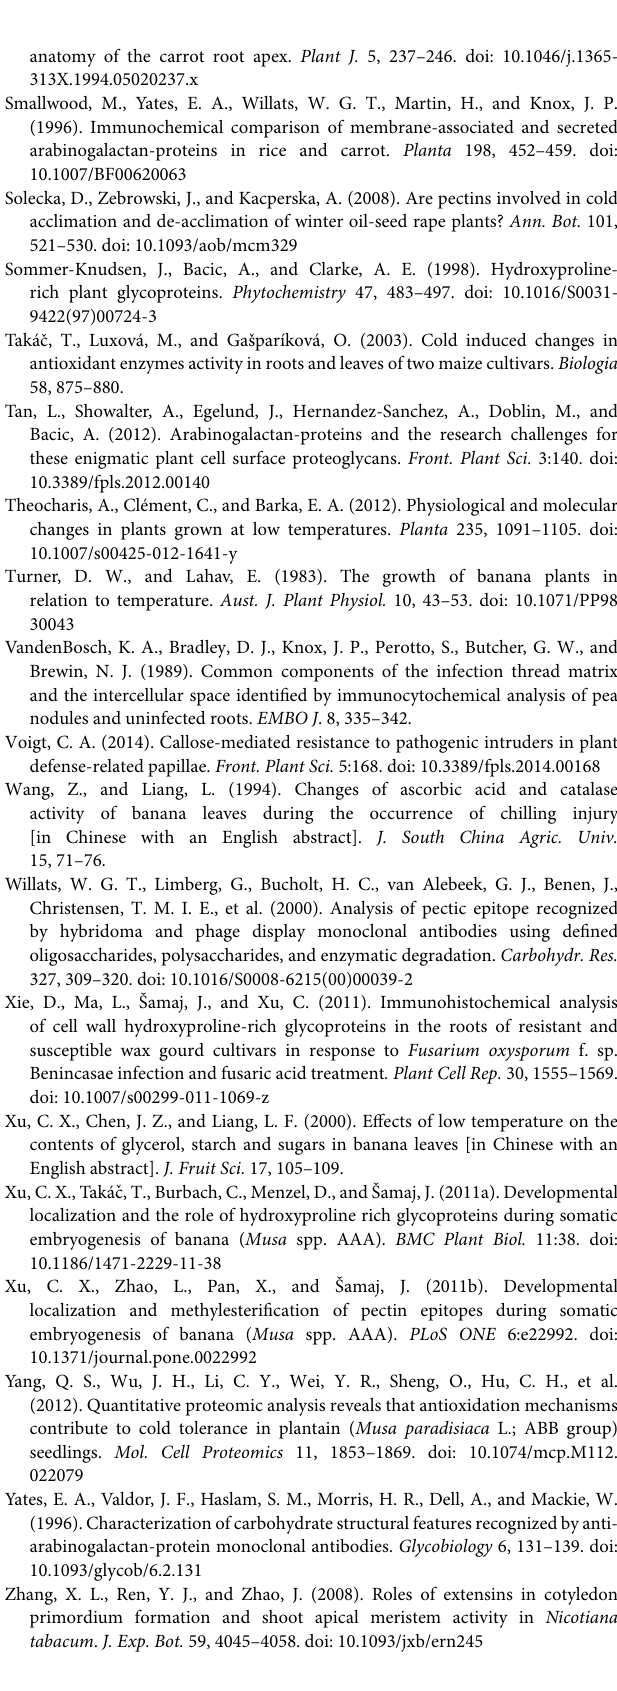
tabacum . J. Exp. Bot. 59, 4045–4058. doi: